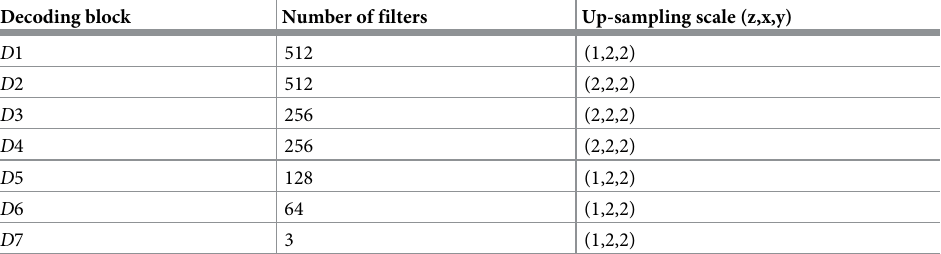
Table 2. The number of filters and up-sampling scales that were used in the three-dimensional Pix2Pix GAN’s decoding blocks. Decoding block